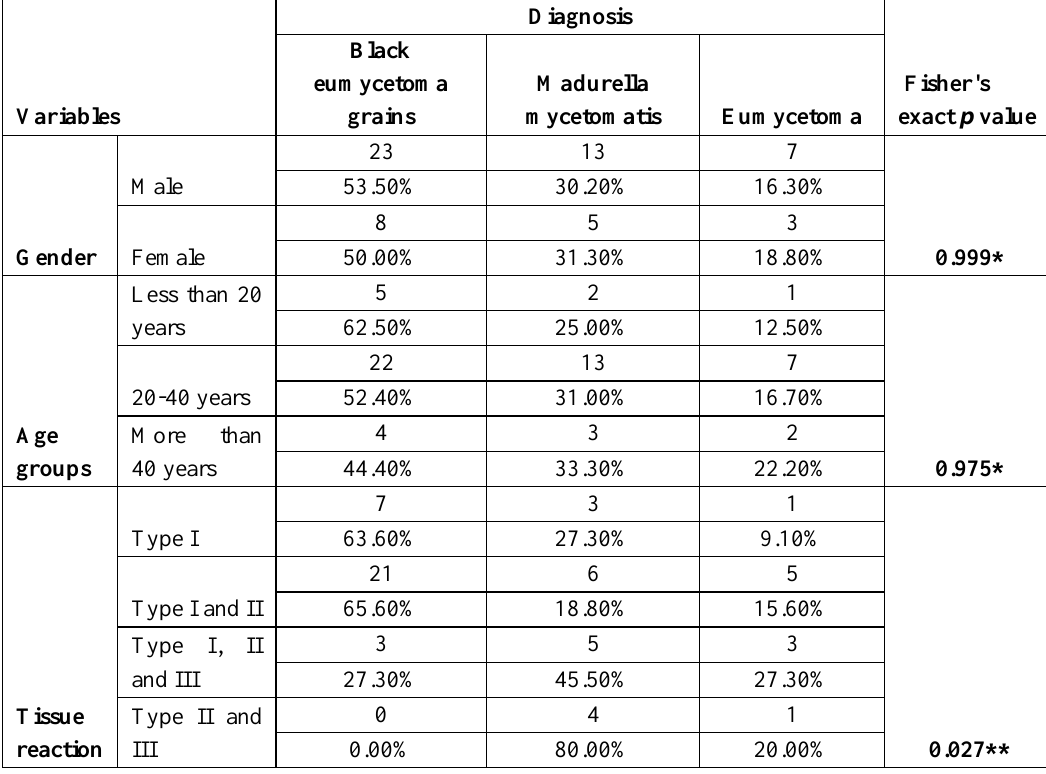
Table 4. Correlation between diagnosis in relation to gender, age and host tissue